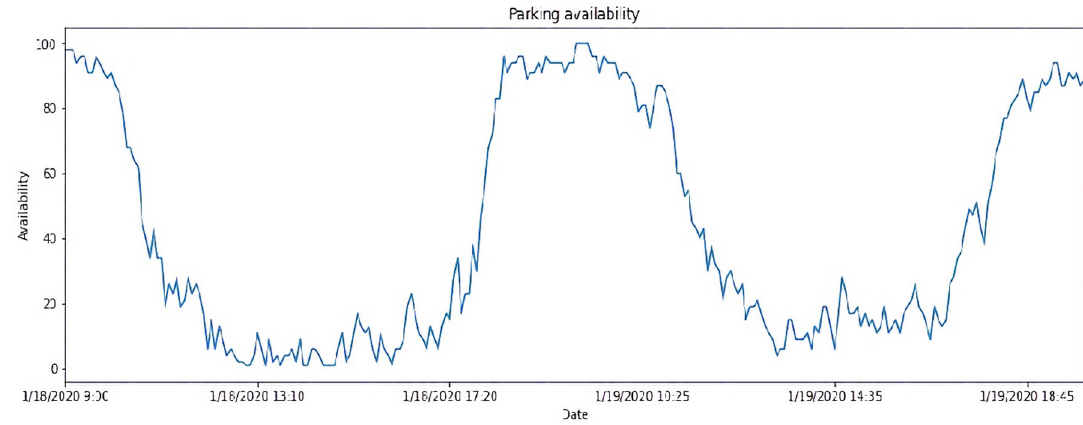
Figure 3: Parking availability during a weekday ( January 18, 2020 ) and a weekend ( January 19, 2020 )